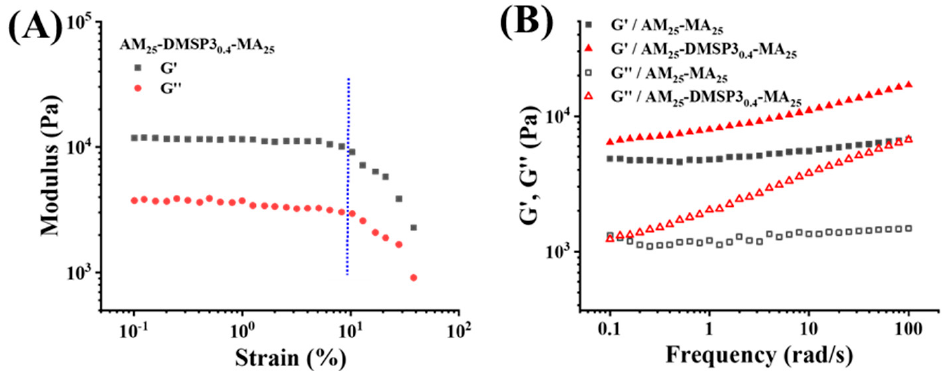
Figure 3. ( A ) The strain amplitude sweep test of AM 25 –DMSP3 0.4 –MA 25 hydrogel at a fixed angular frequency (10 rad/s) at 25 °C; ( B ) Variation of storage modulus G’ and loss modulus G ″ as a function